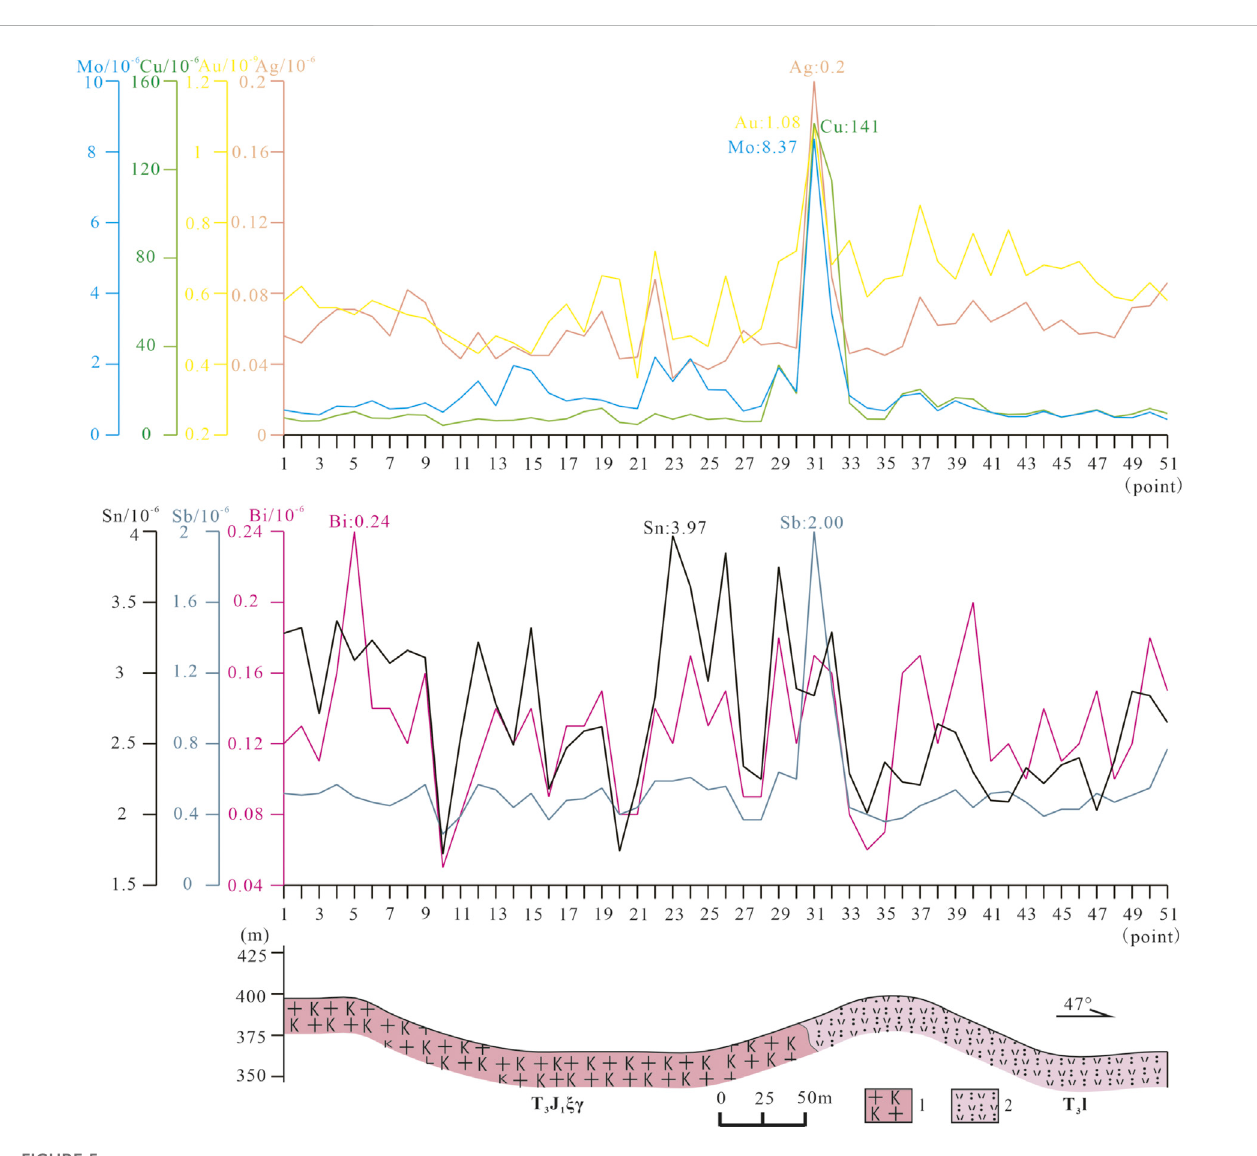
FIGURE 5 Integrated section of Line P7 in the Xinchenggou area, Dongning County. 1-Late Triassic-Early Jurassic syenogranite; 2-Late Triassic Luoquanzhan Formation.